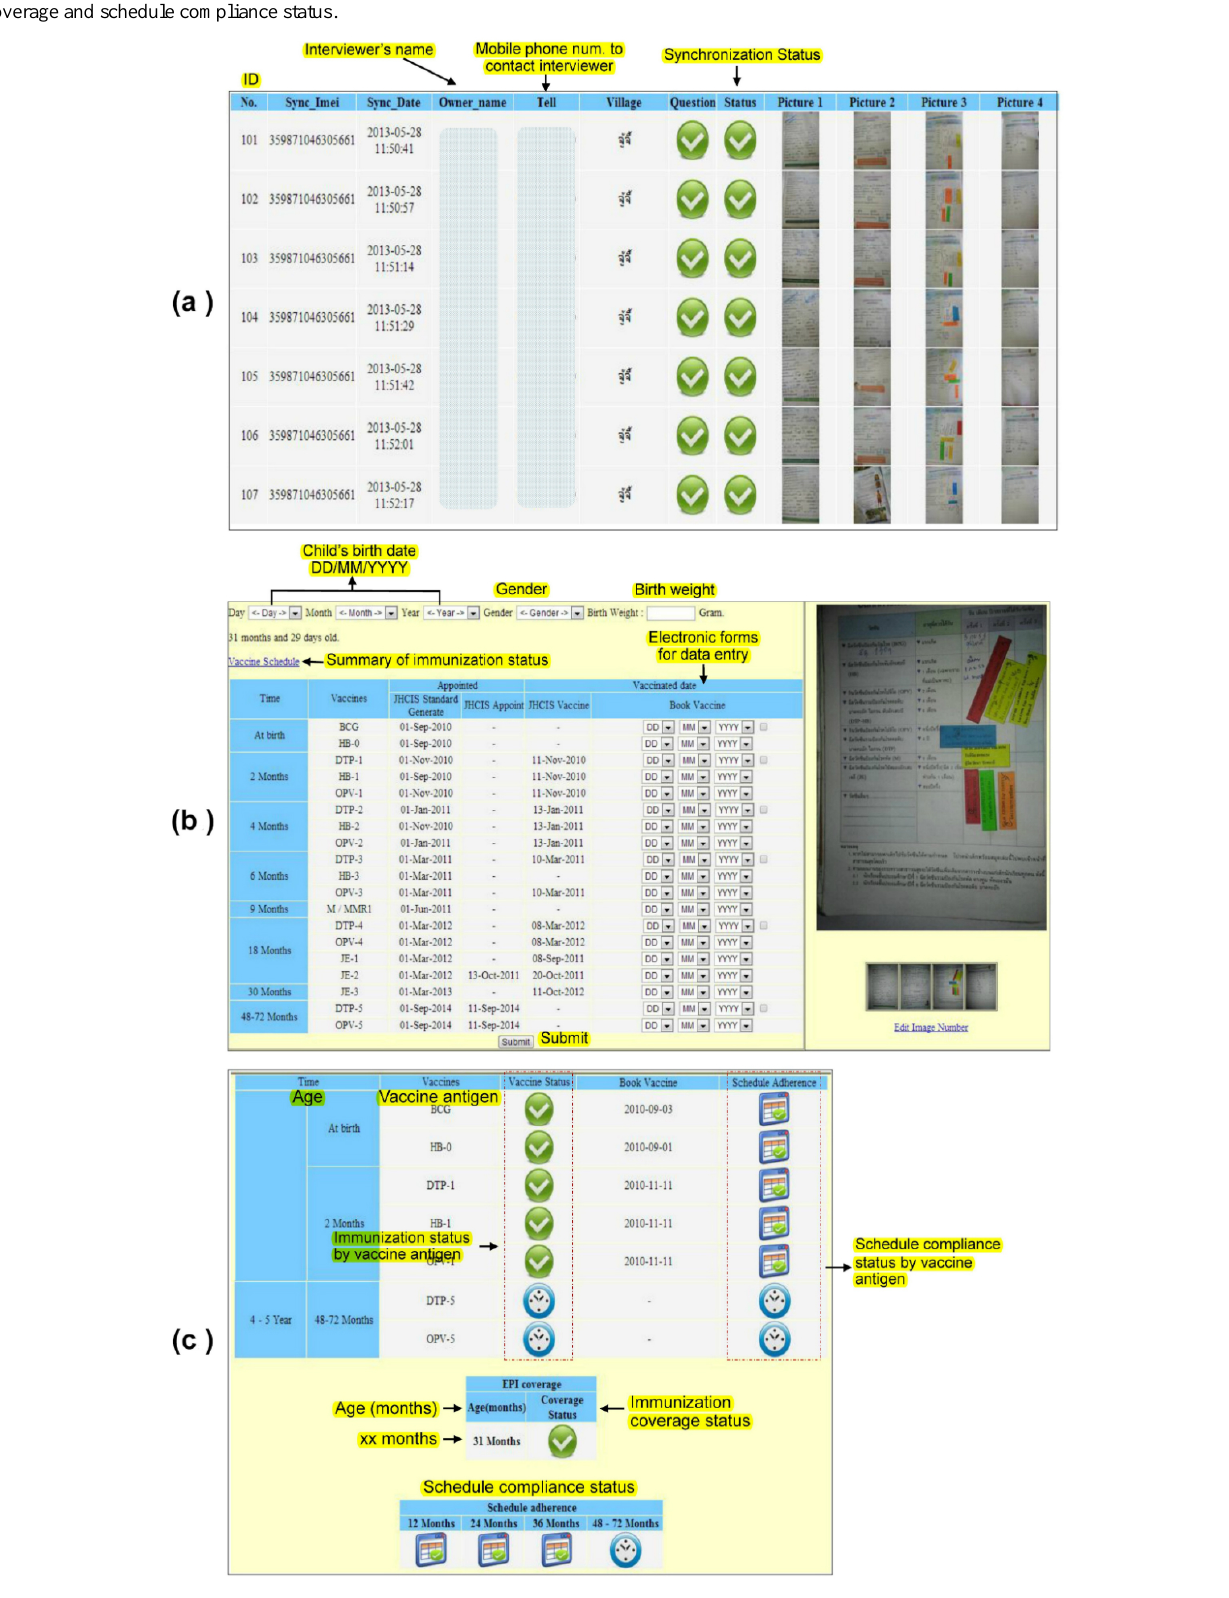
Figure 4. (a) Data monitoring on web-based, (b) immunization history data entry from captured picture, and (c) summary of individual immunization coverage and schedule compliance